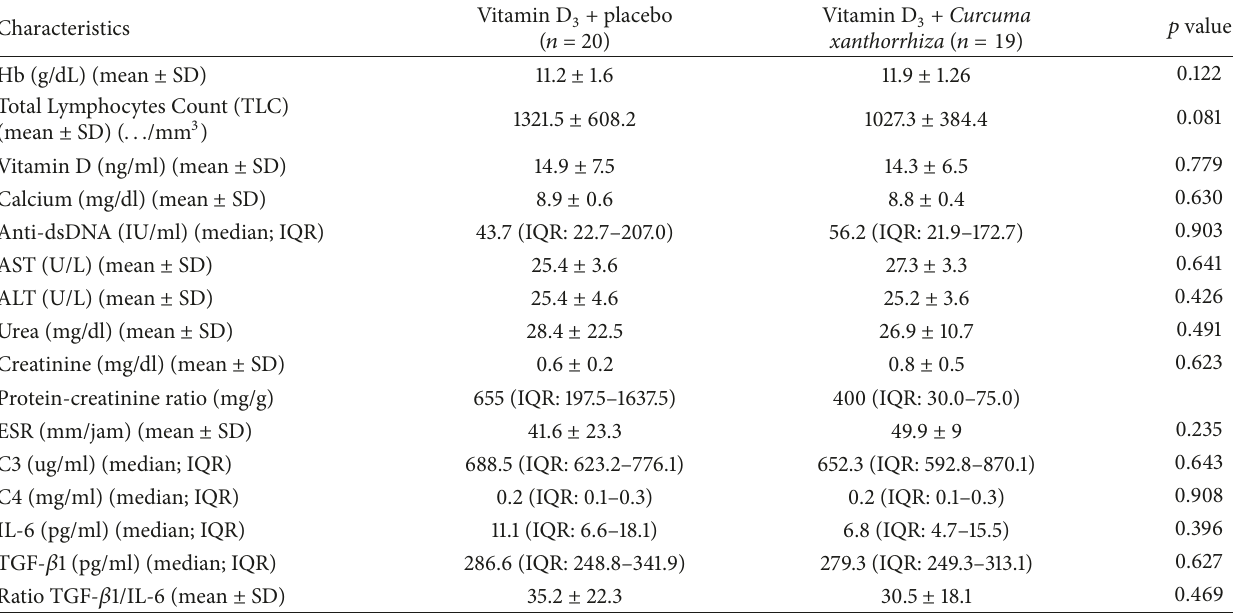
Table 2: Laboratory characteristics of research subjects.